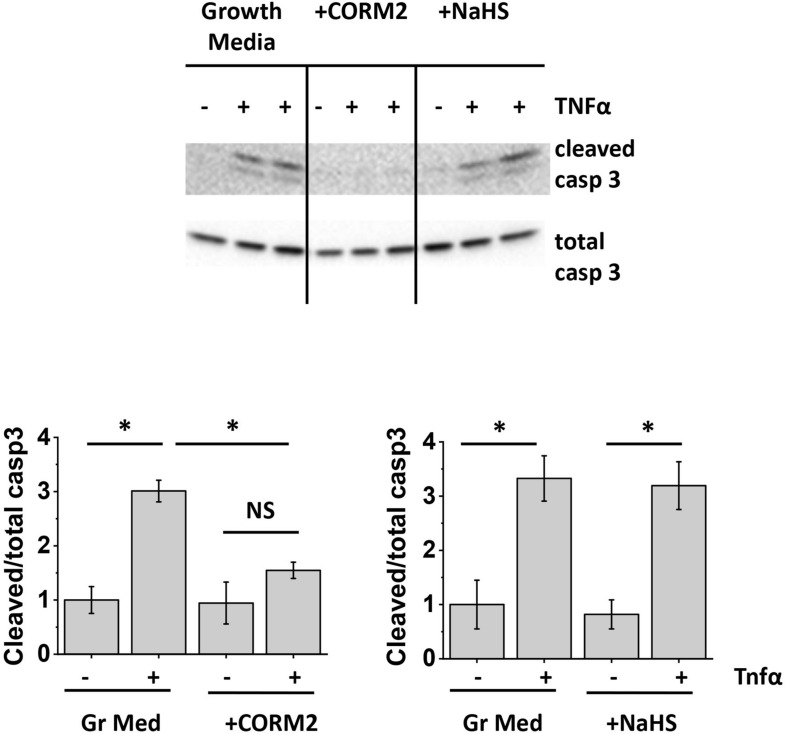
Carbon monoxide protects the endothelium from apoptosis. HPAEC were exposed to the original growth media or growth media supplemented with 50 μM CORM2 (CO donor) or 50 μM NaHS (H2S donor). After 48 h, media was removed; cells were stimulated with 2 ng/ml TNFα. Cell lysates were analyzed with antibodies to cleaved and total caspase 3. Data from three independent experiments were pooled and presented as cleaved/total caspase 3 ratio mean ± SEM. One-way ANOVA with Tukey post hoc was used to detect whether differences between indicated columns are significant ∗(p < 0.05) or not significant (NS).